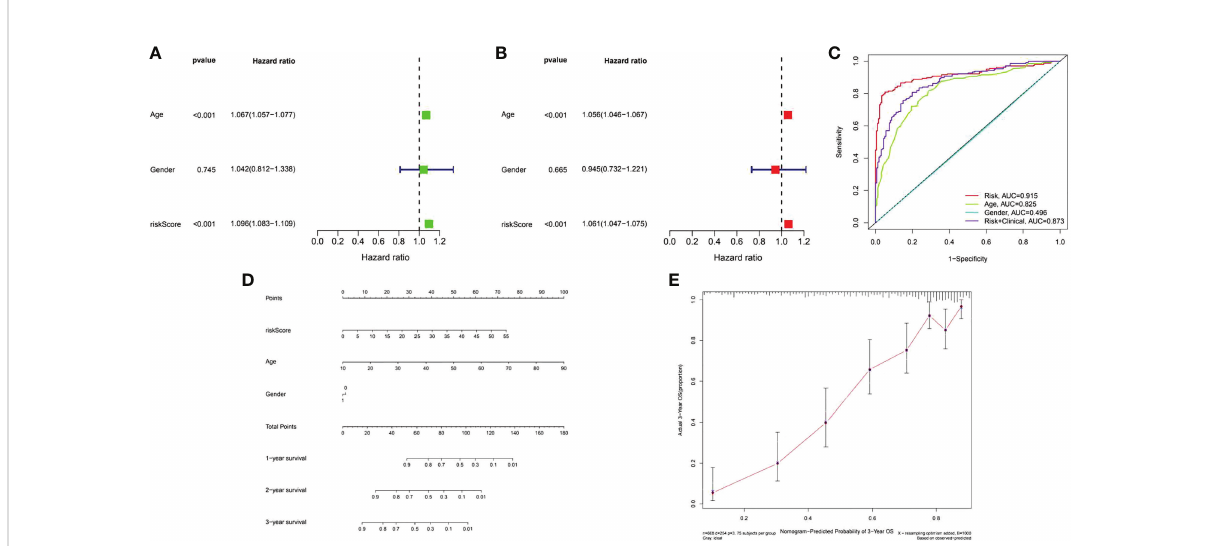
FIGURE 15 Assessment of the prognostic risk model of the 16 COL6A2 related immune genes in glioma. (A) The univariate and (B) , multivariate Cox regression analysis of risk model score and clinical features regarding prognostic value. (C) The AUC for risk model score and clinical features according to the ROC curves. Clinical features: age, gender, Risk, AUC=0.915, age, AUC=0.825, gender, AUC=0.496, risk + clinical, AUC=0.873. (D) Nomogram predicting OS of glioma patients from TCGA. (E) The calibration plot of the nomogram, the y ‐ axis represents actual survival, and the x ‐ axis represents nomogram predicted